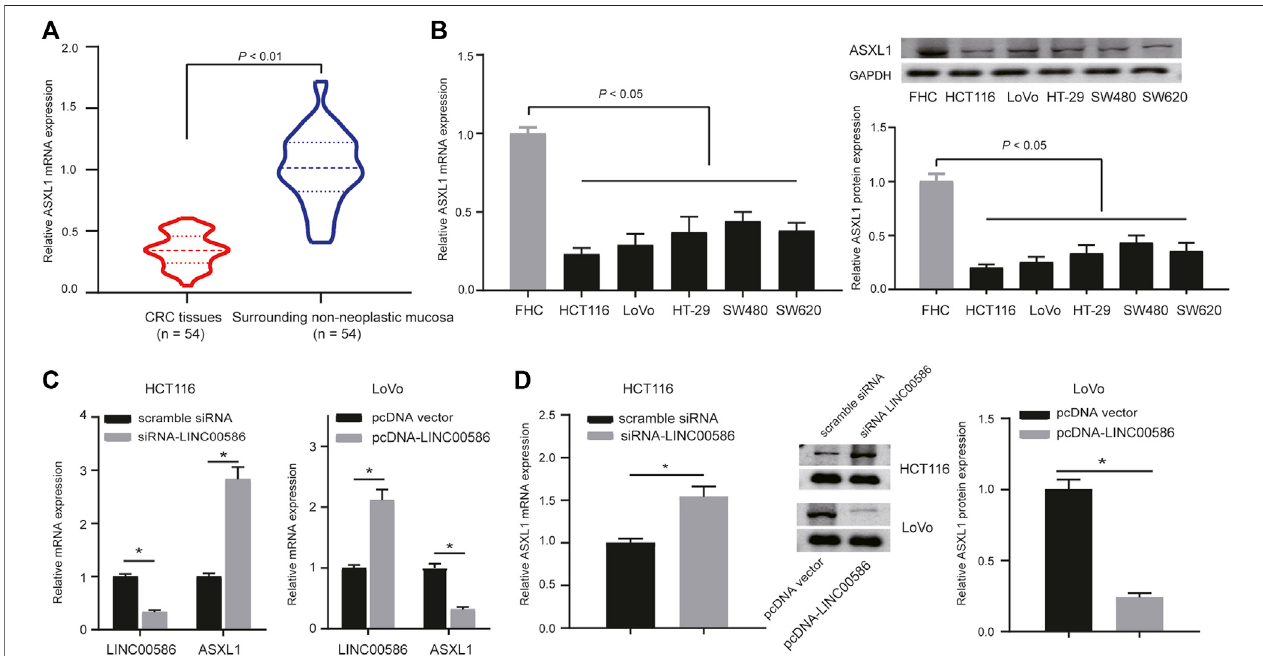
FIGURE 3 | High expression of LINC00586 inhibits the expression of ASXL1 in CRC cells. (A) The mRNA and protein expression of ASXL1 was analyzed by real- timeqPCR and immunoblotting analysis in CRC tissues ( n = 54) and surrounding non-neoplastic mucosa ( n = 54). (B) The mRNA and protein expression of ASXL1 was analyzed by real-time qPCR and immunoblotting analysis in a panel of CRC cell lines (HCTl16, LoVo, HT-29, SW480, and SW620) and FHC. (C,D) , The mRNA and protein expression of ASXL1 was analyzed by real-time qPCR (C) and immunoblotting analysis (D) in HCTl16 and LoVo cells upon LINC00586 knockdown or overexpression. * p < 0.05 by unpaired t test or by one-way ANOVA with Tukey ’ s test [only for (B)